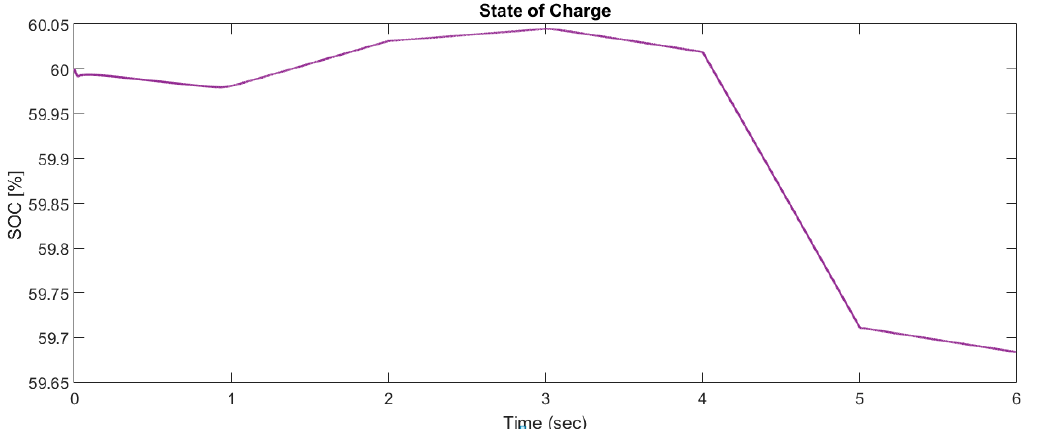
Figure 16. Battery bank voltage and current.